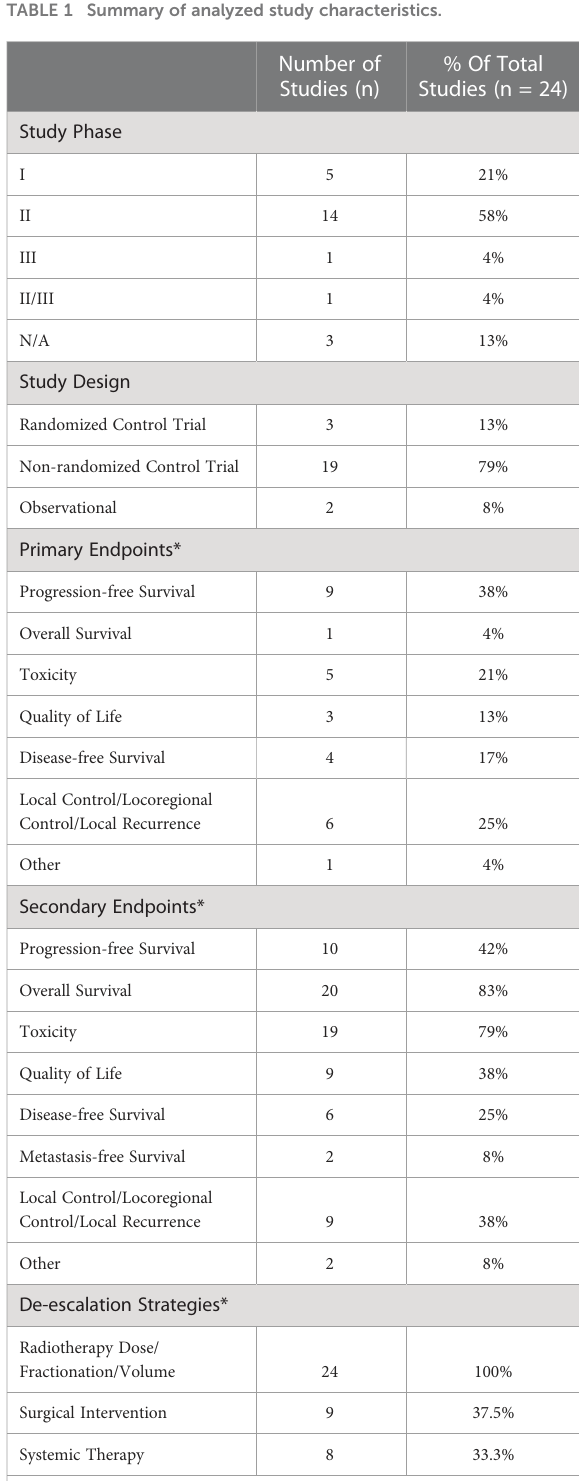
TABLE 1 Summary of analyzed study